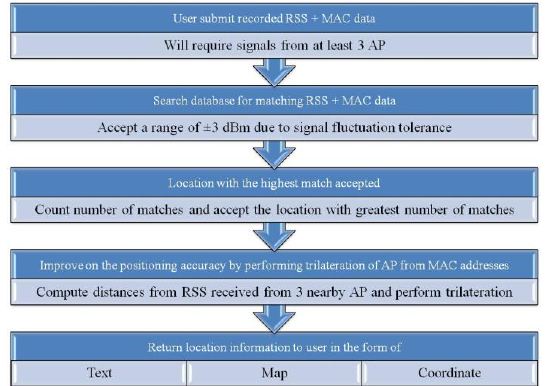
Figure 4 – Sequential flowchart presenting the logic of the system